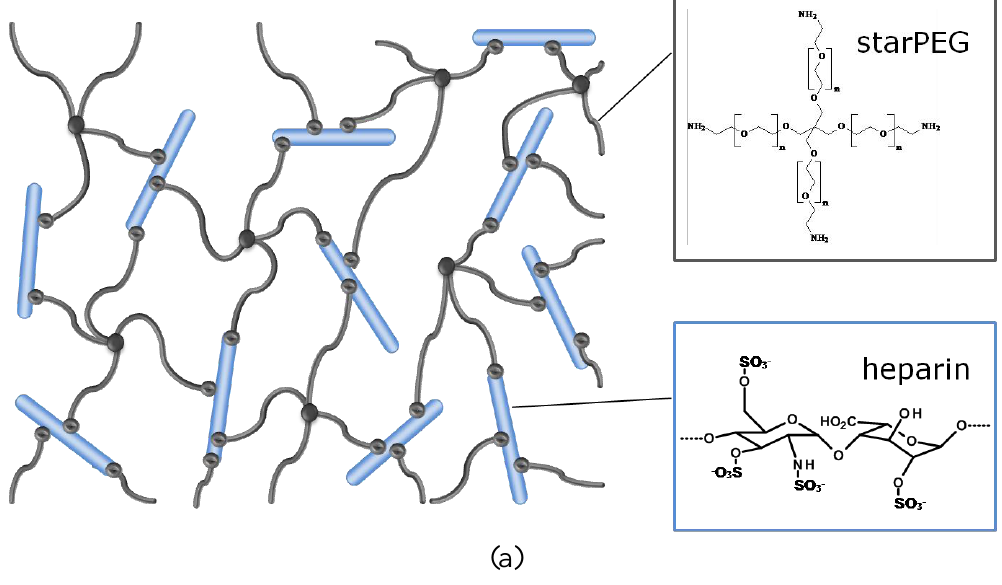
Figure 1. ( a ) Design of the starPEG heparin hydrogels. ( b ) Variation of heparin and starPEG building